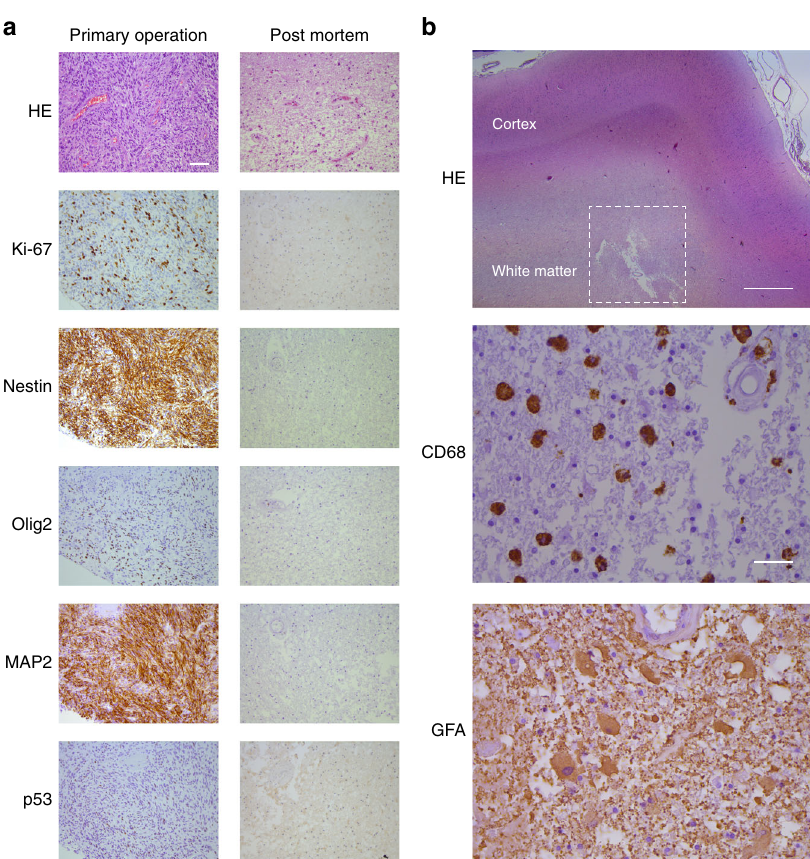
Fig. 7 Treatment response in Patient 6. a Immunohistochemical analysis of Ki-67, Nestin and GBM markers in biopsies obtained at diagnosis (tumor) and autopsy (previous tumor location), × 200 objective; scale bar = 50 µ m. b Low-magni fi cation ( × 12.5 objective; scale bar = 1 mm) overview of the affected brain region from the autopsy specimen (HE) and immunohistochemical analysis of the macrophage lineage marker CD68 and the astrocyte marker GFA, × 400 objective; scale bar = 25 µ m. The previous tumor location area analyzed by immunohistochemistry, including the necrotic cavity, is indicated by dashed